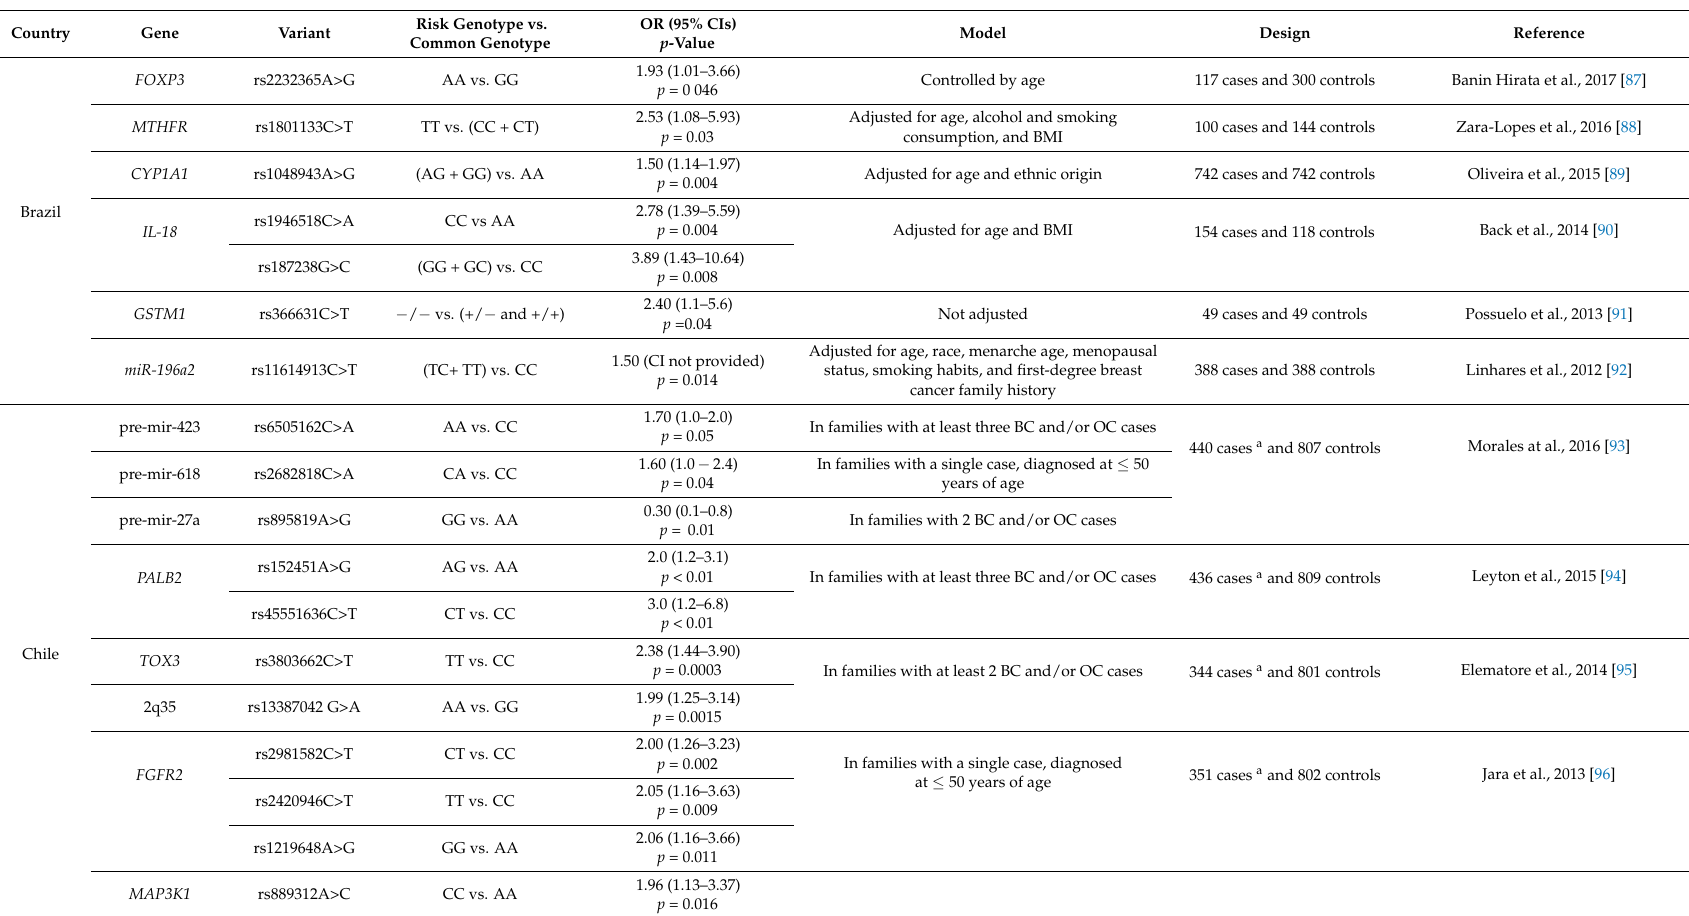
Table 1. Summary results from breast cancer candidate gene studies in Latin America showing a positive association with cancer risk ( p ≤